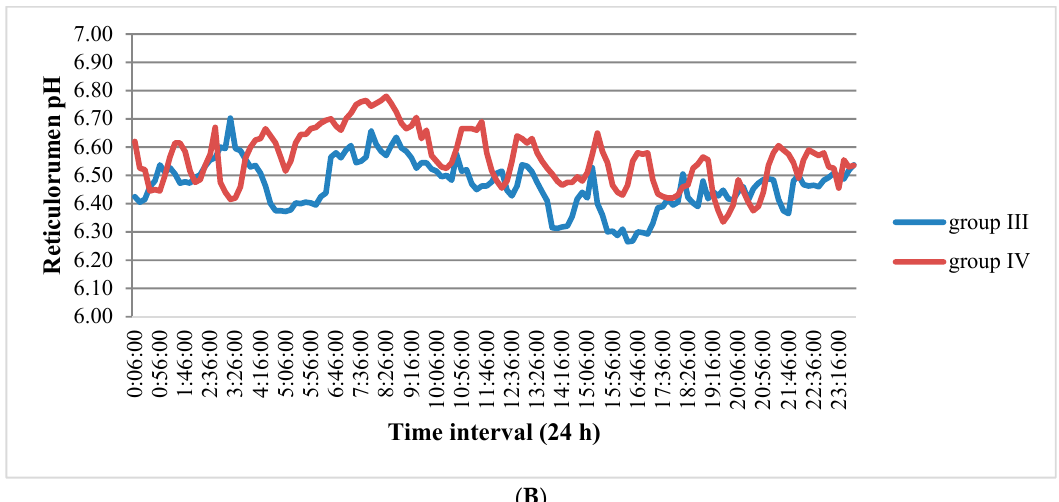
Figure 2. ( A ). Reticulorumen pH changes during 24 h by reproduction status of cows. Group I: 15–30 days postpartum, Group II: 1–34 days after insemination. ( B ). Reticulorumen pH changes over 24 h by reproduction status of cows. Group III: 35 days after insemination (non-pregnant), Group IV: 35 days after insemination (pregnant).